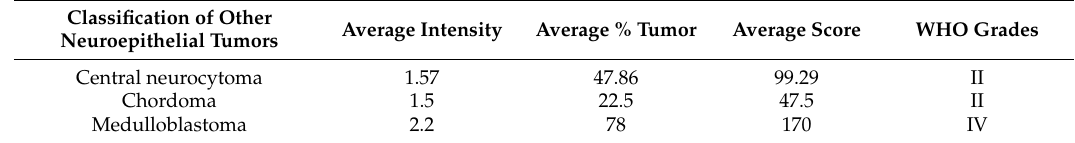
Table 4. Nrf2 immunostain scores in other neuroepithelial tumors.